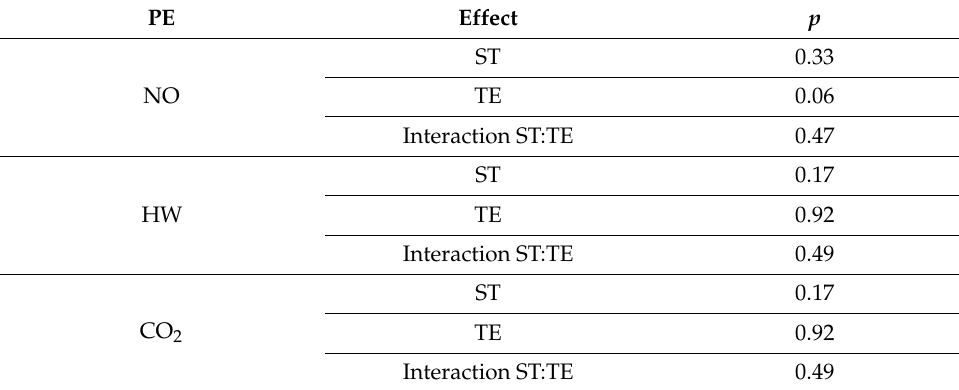
Table 4. Fixed pre-etching treatment—two-way ANOVA *.